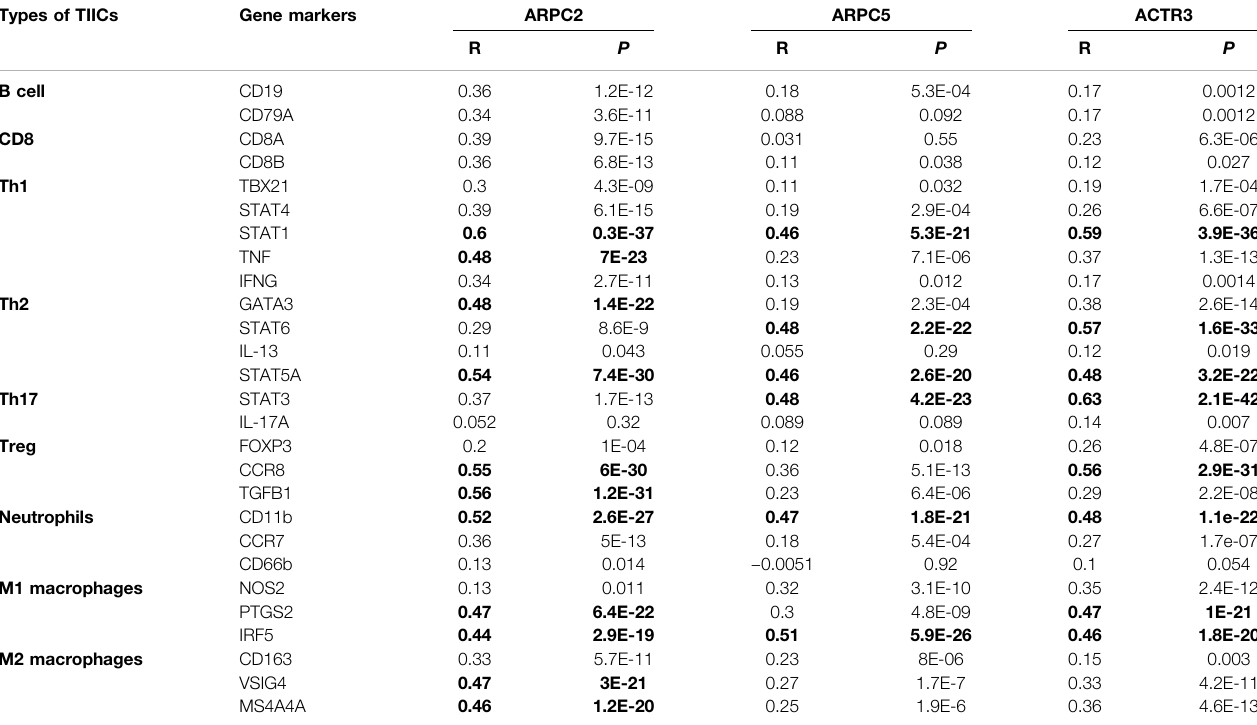
TABLE 2 | Correlations between signi fi cant prognostic Arp2/3 subunits ’ expression and biomarker expression of subsets of TIICs in HCC. Types of TIICs Gene markers